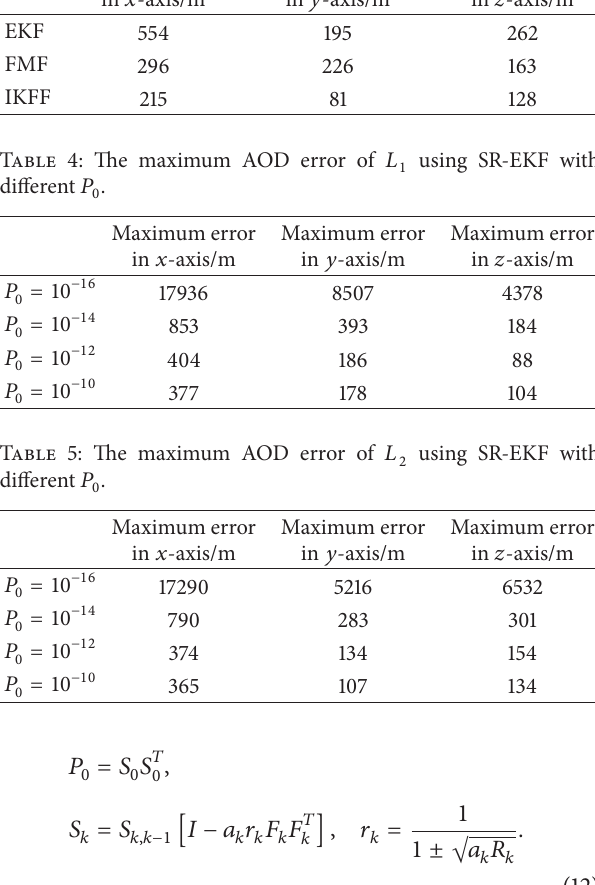
Figure 10: The AOD position error of 𝐿 2 using IKFF.